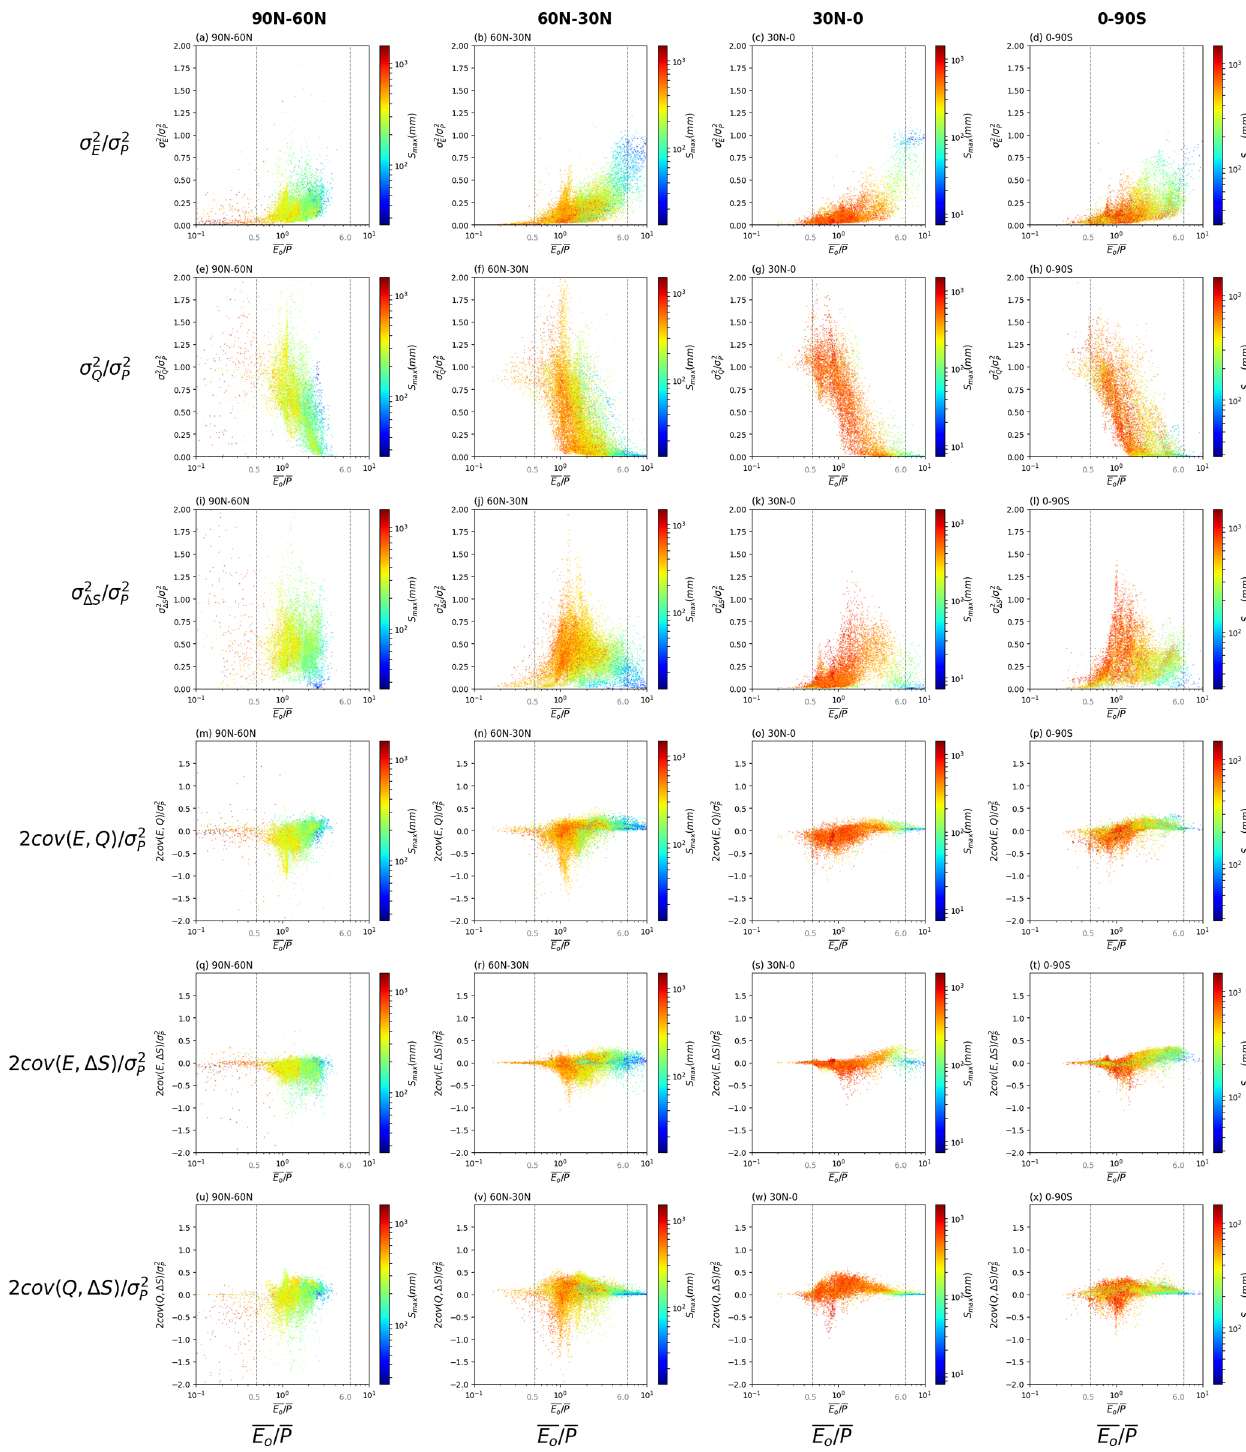
Figure 7. Relation between water cycle variances and covariances (see Fig. 3b–g) as a fraction of the variance for P ( σ 2 index ( E o /P ) for grid cells over different latitude ranges (i.e. 90–60 ◦ N, 60–30 ◦ N, 30–0 ◦ N and 0–90 ◦ S). The colours relate to the water storage capacity S max . Note that we have multiplied the covariances by two (see Eq. 2). The vertical grey dashed lines represent thresholds used to separate extremely dry ( E o /P ≥ 6 . 0) and wet ( E o /P ≤ 0 . 5) environments. Note the use of a logarithmic x axis and scale bar for S max